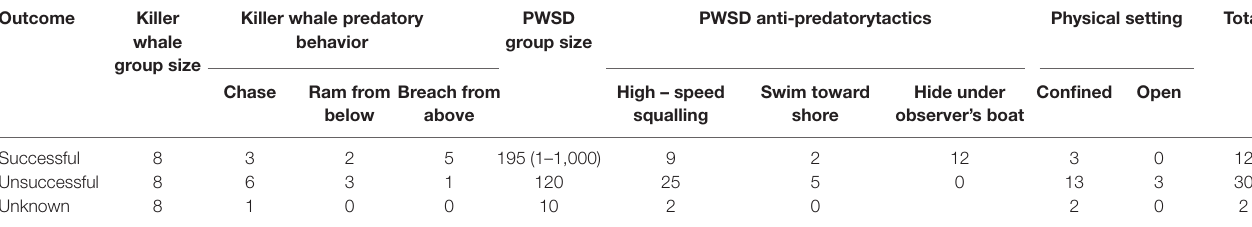
TABLE 1 | A summary of records killer whale predation attempts on Pacific white-sided dolphins in the